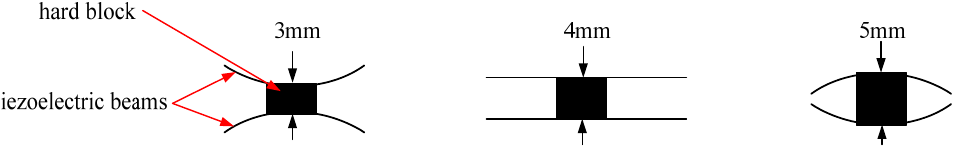
Figure 15. The initial piezoelectric beam shapes with different hard block thicknesses.